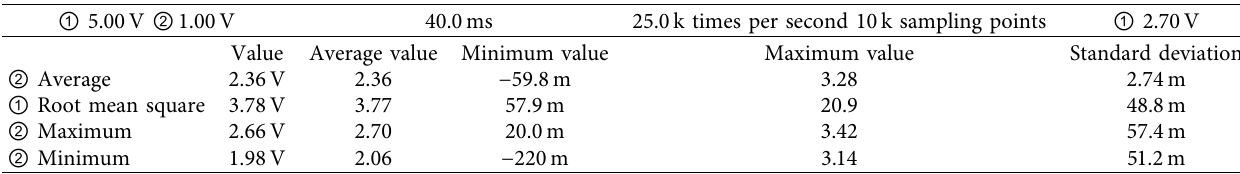
Table 2: Text description in Figure